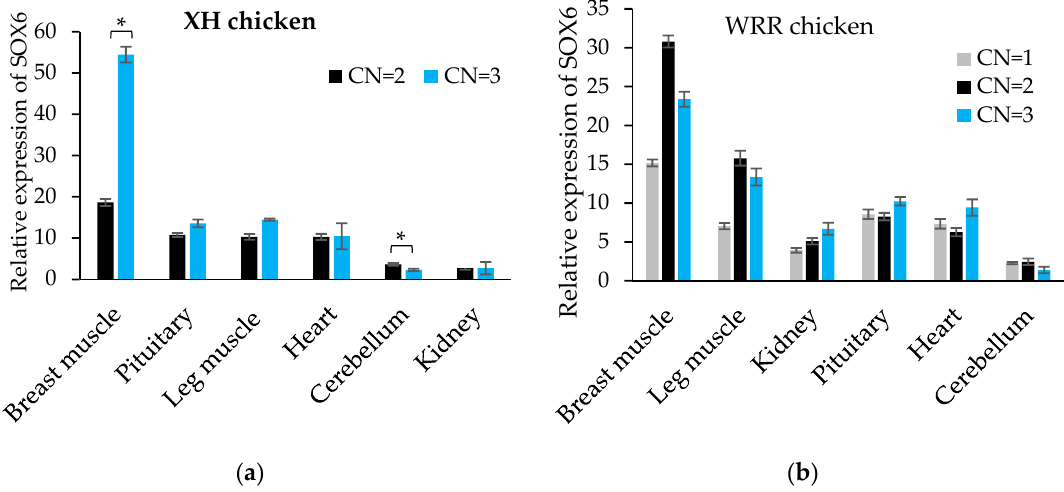
Figure 6. The expression levels of SOX6 in XH and WRR chickens with different copy numbers. ( a , b ) The relative expression levels of SOX6 in six tissues of both XH chicken with CN = 2 or 3 and WRR chicken with CN = 1, 2 or 3, respectively. The Significance: * indicates p < 0.05. Table 7. The significance of association between SOX6 RNA expression and copy number ( p -value). Breast Muscle